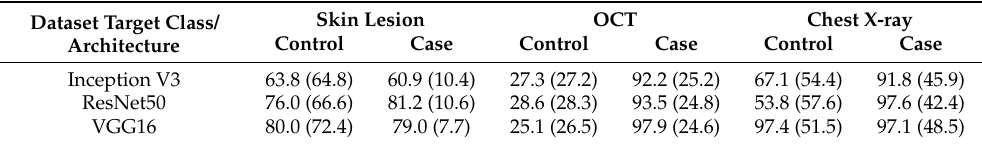
Table 2. Target attack success rates R s (%) of UAPs for targeted attacks against the DNN models for medical image datasets. Values in brackets indicate random controls ( R s of random